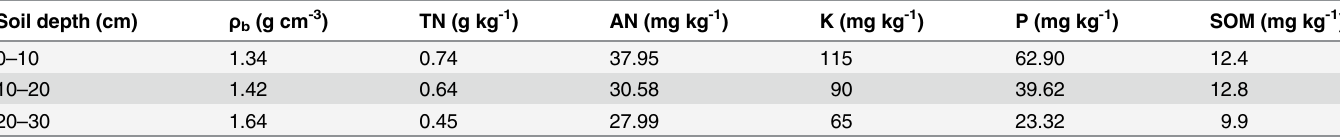
Table 1. Principle soil properties before